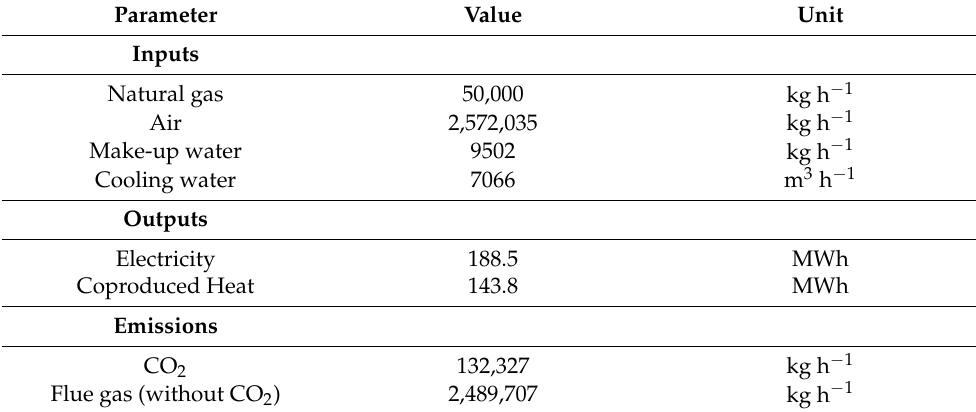
Table 1. Inventory for the NGCC power plant operation.